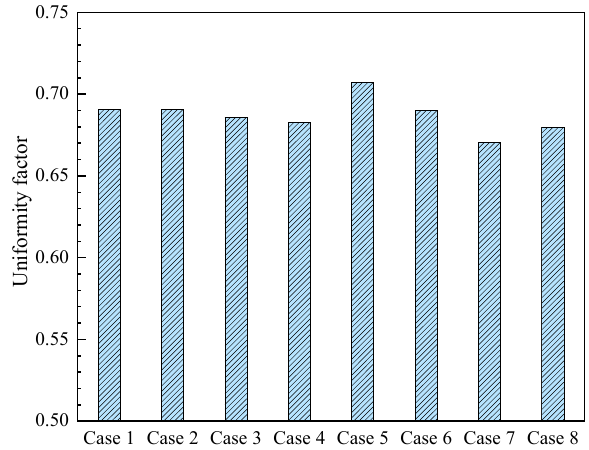
Figure 10. Uniformity of the current density distribution in the middle plane of CCL for various designs.